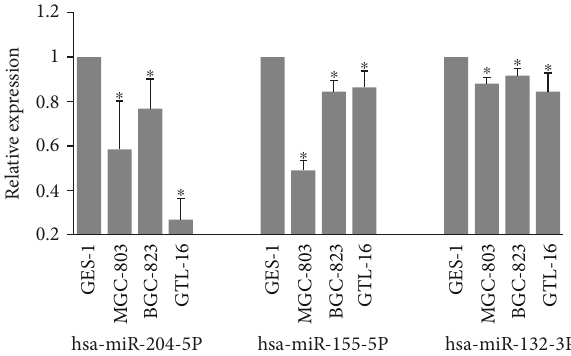
Figure 3: The expression levels of hsa-miR-204-5p, hsa-miR-155- 5p, and hsa-miR-132-3p were relatively downregulated in three human GC cell lines. The expression levels of the three GC cell lines (MGC-803, BGC-823, and GTL-16) were calculated as relative expression to that of the control group, that is, the normal gastric epithelial cell line (GES-1). Experiments were performed in triplicate. Data are expressed as mean ± SD. An asterisk ( ∗ ) indicates p < 0 05 (versus that in